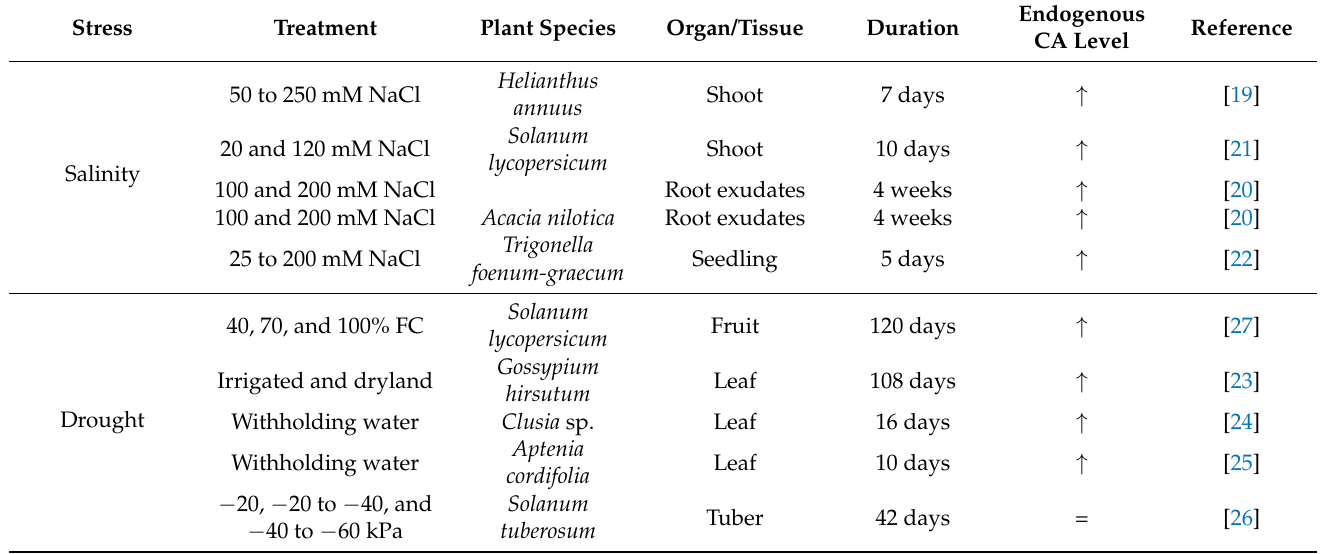
Table 1. Published effects of abiotic stresses on endogenous CA levels in plants.